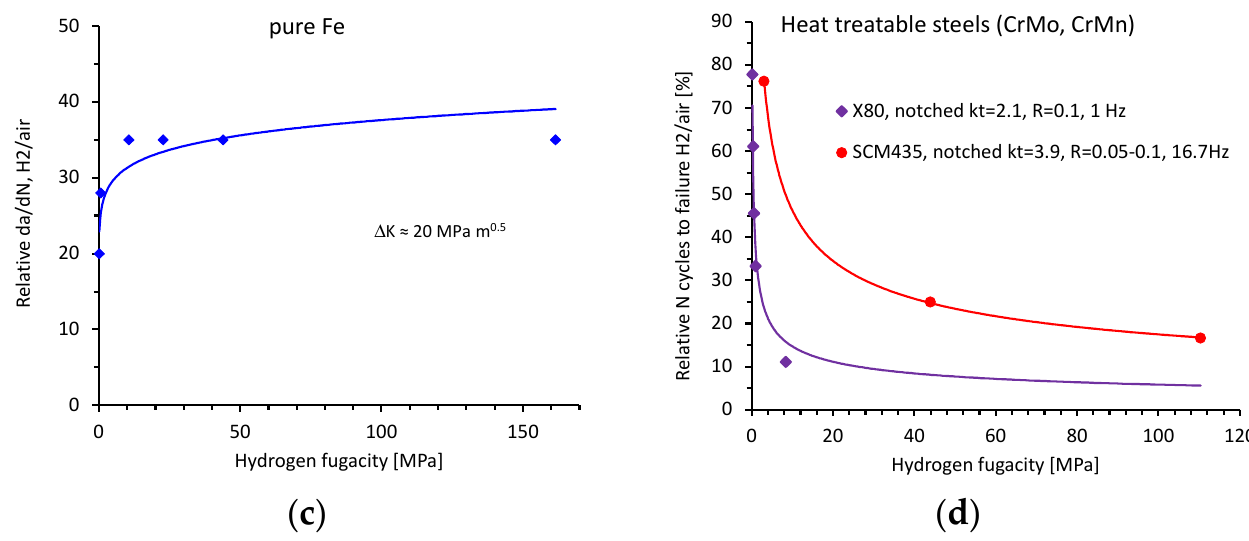
Figure 3. Results of the cyclic crack growth tests (da/dN) and fatigue life tests measuring the number of cycles to failure (N f ) as a function of hydrogen test pressure. Relative da/dN for ( a ) carbon steels, ( b ) heat-treatable steels and ( c ) pure iron. ( d ) Relative number of cycles to the failure of heat-treatable steels. References, test details and fit parameters are given in